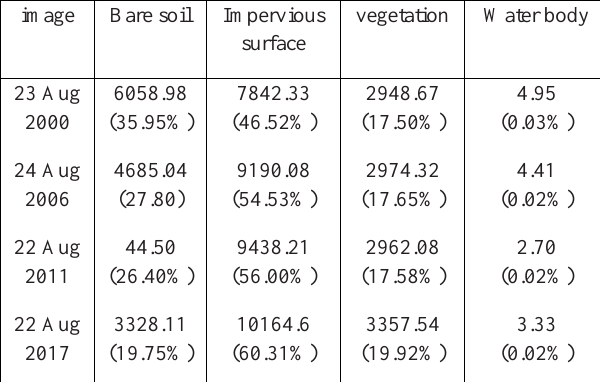
Table 2. Image classification and accuracy assessment Image classification results shown on table